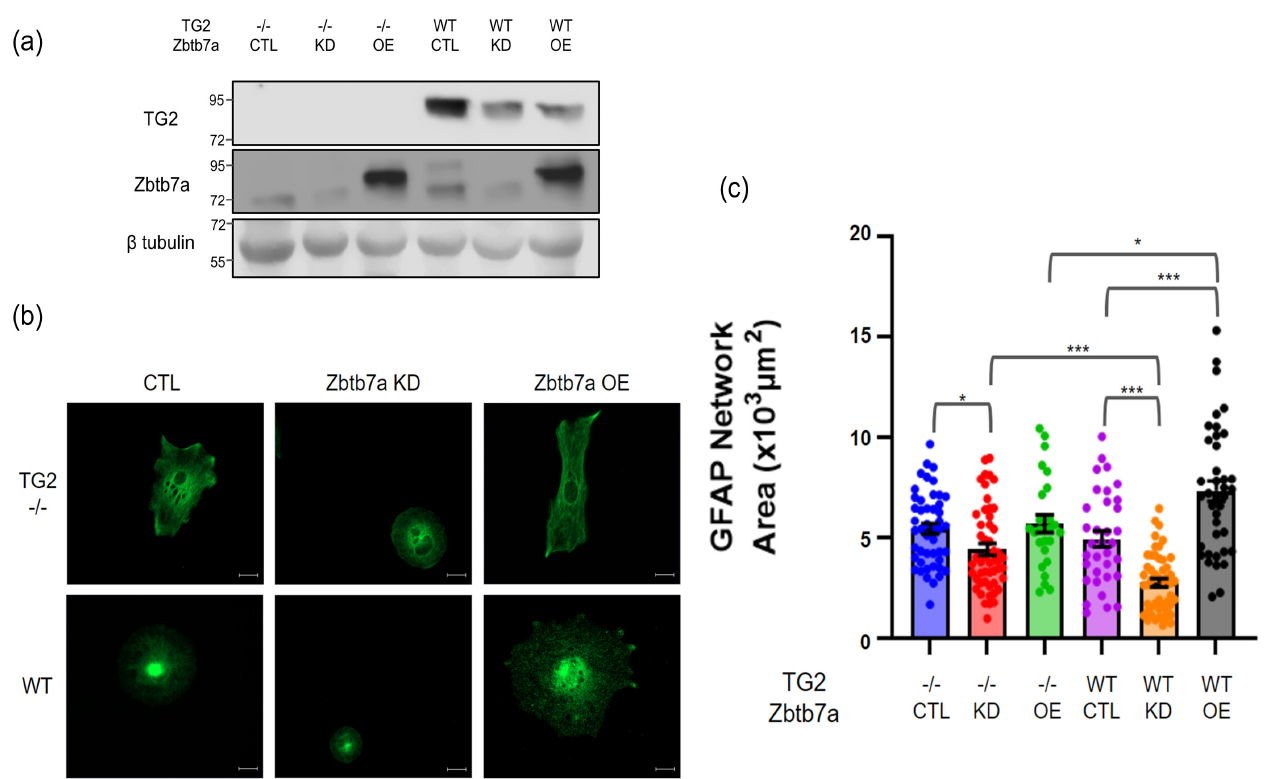
Figure 4. Manipulating the expression of Zbtb7a in WT and TG2 − / − astrocytes differentially impacts morphology. ( a ) Immunoblots showing knockdown (KD) or overexpression (OE) of Zbtb7a, compared to control (CTL), in WT and TG2 − / − astrocytes. Since the Zbtb7a OE virus encodes human Zbtb7a, the Zbtb7a bands in these samples migrated slightly faster than bands in the CTL and KD samples from mouse astrocytes. ( b ) Representative images of the astrocyte GFAP network in the different conditions (scale bar = 20 µ m) and ( c ) Quantitation of GFAP network area (n = 34–50 astrocytes per condition from two independent biological replicates, Two-way ANOVA * p < 0.05, *** p < 0.001). To begin to investigate the functional relevance of the TG2-Zbtb7a interaction we manipulated Zbtb7a in WT and TG2 − / − astrocytes followed by determining how this impacted their ability to support neurite outgrowth using the transwell paradigm. Similar support neurite outgrowth to a significantly greater extent than it impacted that of TG2 − / − astrocytes (Figure 5). As mentioned above, on a permissive matrix there was no difference between the ability of WT and TG2 − / − astrocytes to support neurite outgrowth. However, Zbtb7a knockdown trended toward a reduced ability of only WT astrocytes to support neurite outgrowth while Zbtb7a overexpression significantly and robustly increased the ability of WT astrocytes to support neurite outgrowth. Zbtb7a overexpression in TG2 − / − astrocytes also seemed to increase their ability to promote neurite outgrowth, but not as robustly as was observed with WT